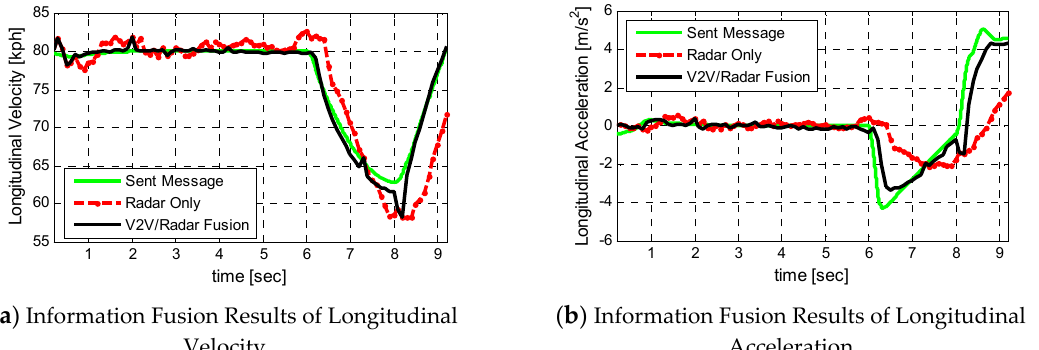
Figure 7. Remote vehicle state estimation results: ( a ) Longitudinal Velocity; ( b ) Longitudinal Acceleration.